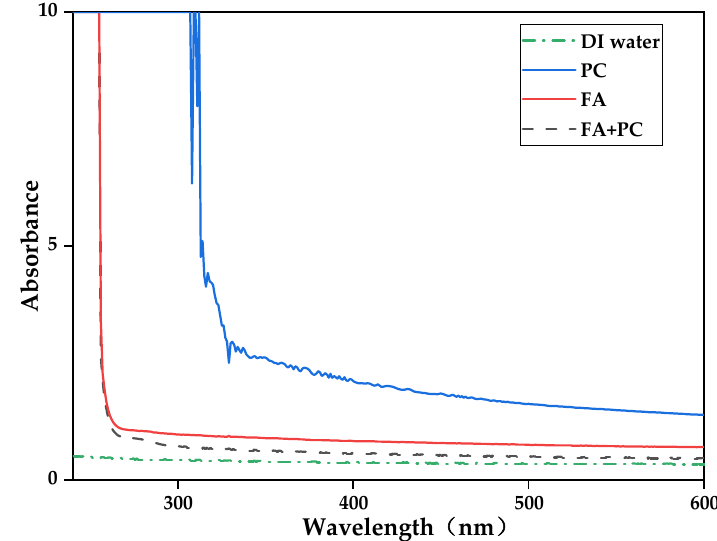
Figure 5. UV–vis spectra of GO dispersed in different solvents.